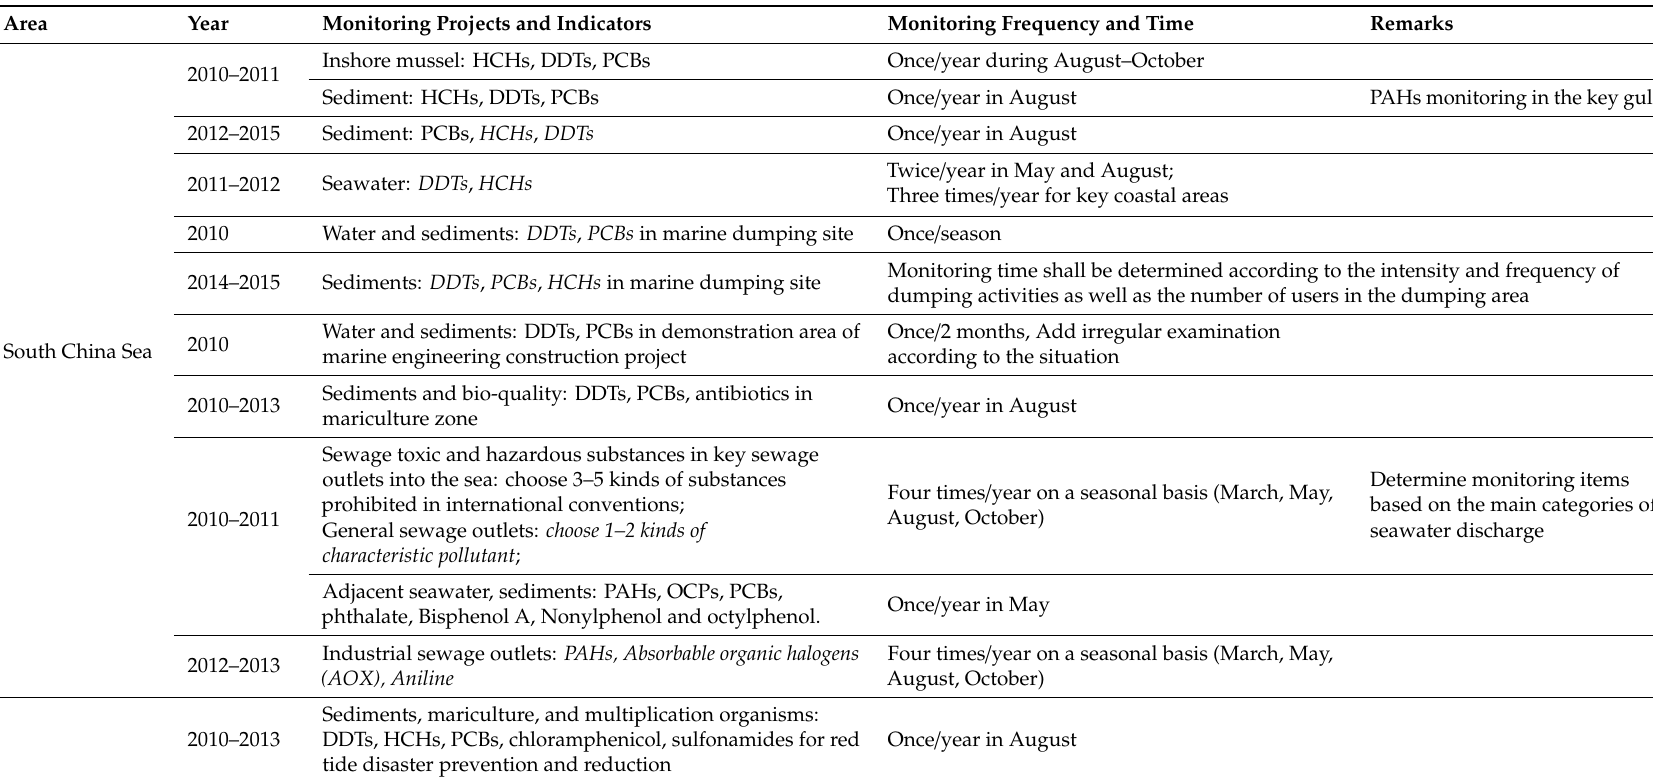
Table 1. Marine monitoring items including persistent organic pollutants (POPs) in the South China Sea during “the 12th Five-Year” Plan of China. Area